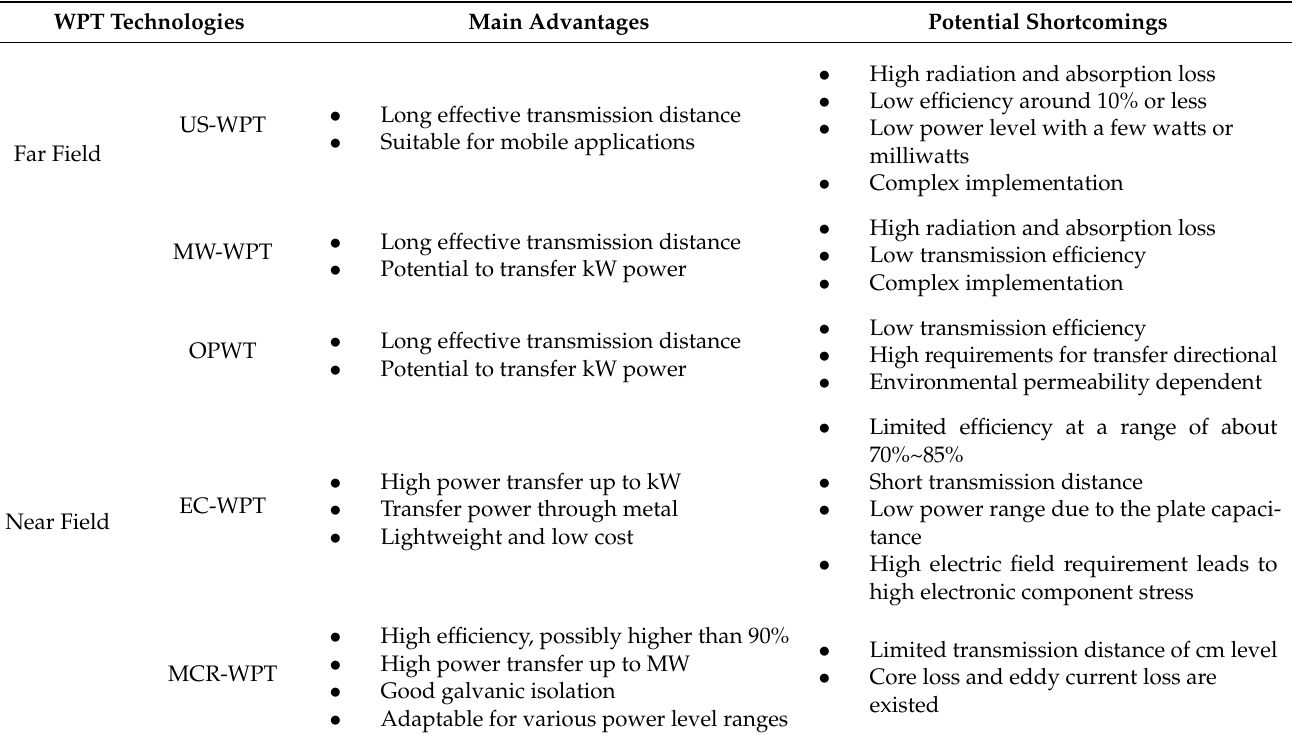
Table 2. Comparison of the main advantages and potential shortcomings of different WPT